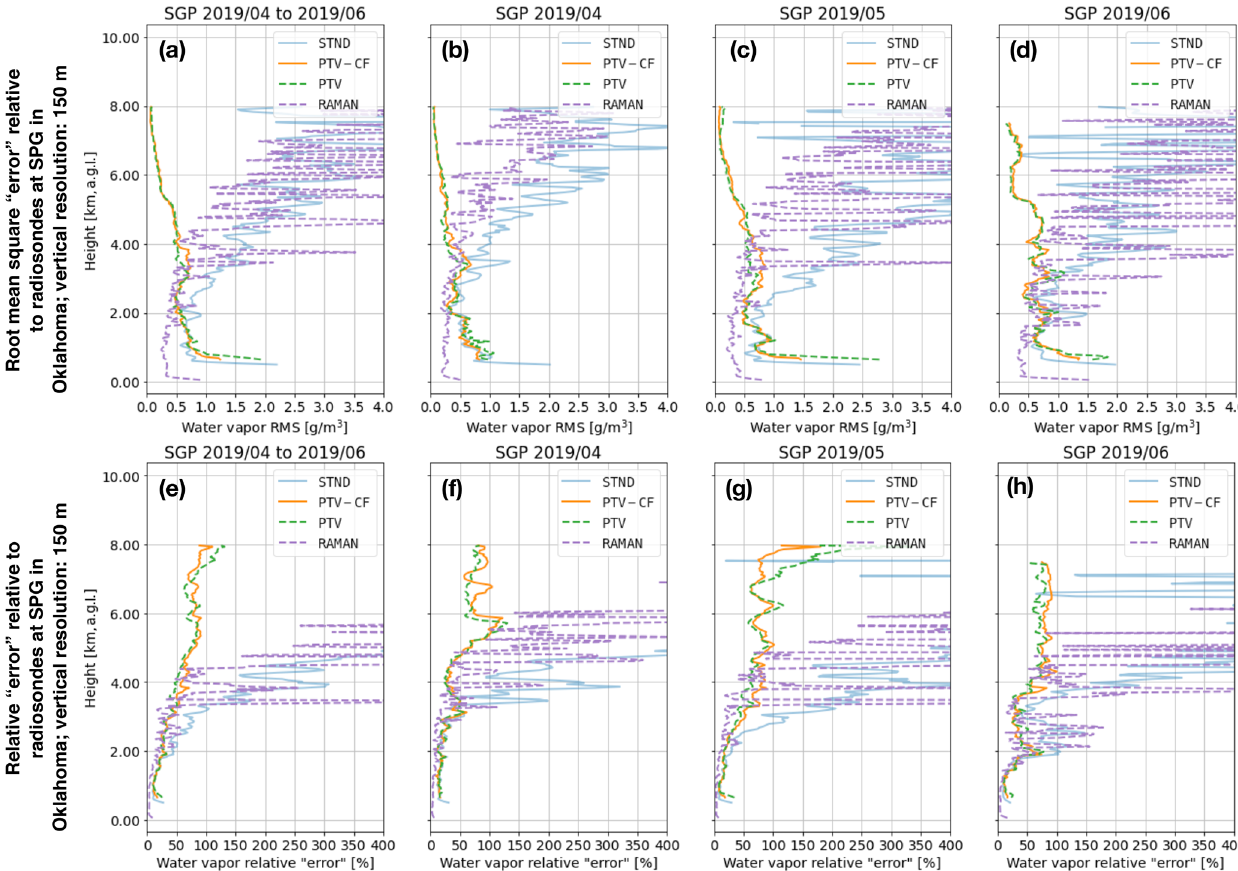
Figure 6. For the all the SGP datasets, (a) shows the root-mean-square “error” (RMSE) relative to the radiosonde (RS) water vapor (WV) measurements for the standard method ( STND ) and the PTV-MPD method with ( PTV-CF ) and without ( PTV ) the coarse-to-fine configura- tion, and (e) shows the corresponding relative RMSE. Panels (b) to (d) show the RMSE for each individual SGP dataset, and (f) to (h) show the corresponding relative RMSE.